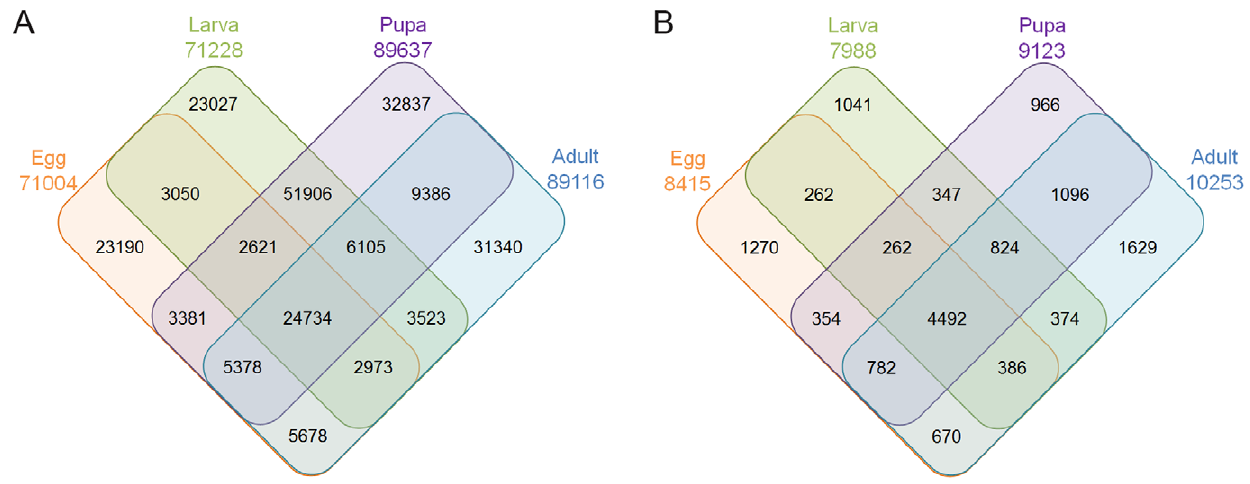
Figure 1. Venn diagram showing unique and shared gene expression among the ACB. ( A ) All clean tag differential expression and co- expression between 2 to 4 developmental stages in four developmental stages (Egg, Larva, Pupa and Adult); ( B ) These tag sequences were mapping by RNA-seq dataset. We obtained 8415, 7988, 9123 and 10253 annotation unigenes for egg, larvae, pupal and adult stages, respectively. Among all of these unigenes, the differential expression and co-expression clean tags and unigenes between 2 to 4 developmental stages were